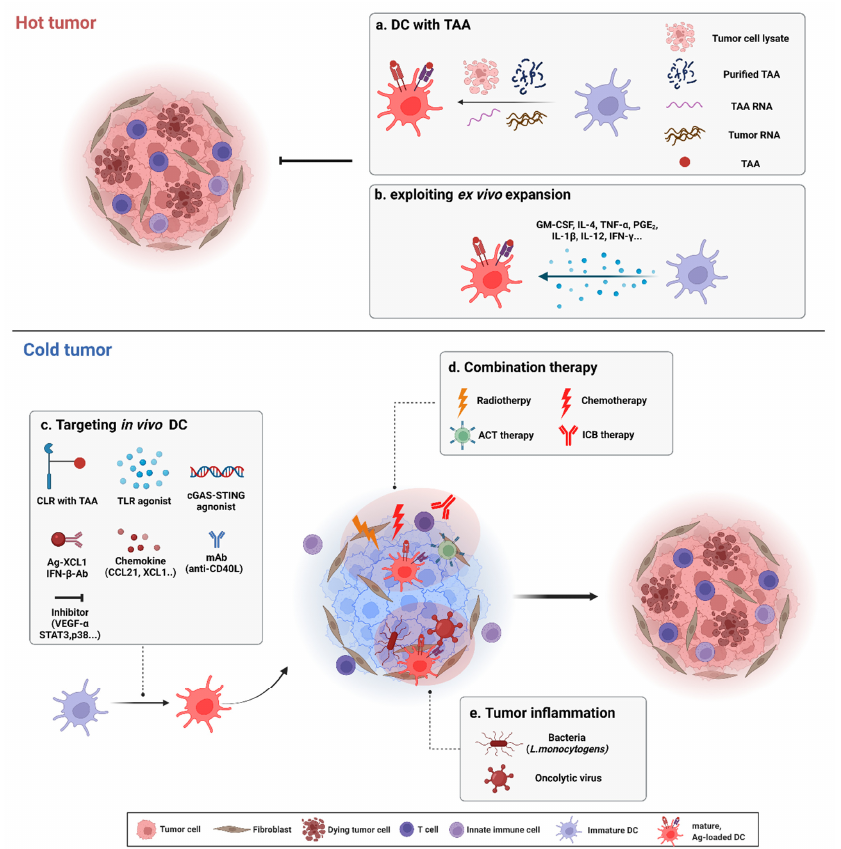
Figure 3. Dendritic cell (DC) ‐ based immunotherapy for hot and cold tumors. Summary of targeting hot and cold tumors using DC ‐ based immunotherapy is illustrated. ( a ) DC pulsed with various form of TAAs: irradiated tumor cell lysate, purified TAA peptide, purified TAA RNA and whole tumor RNA. ( b ) Various cytokines stimulate immature DC. For treatment of cold tumor, strategies to con ‐